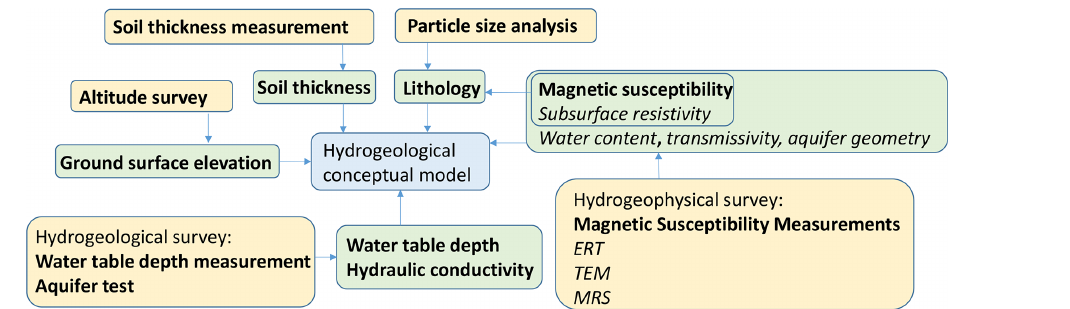
Figure 2. Fieldwork workflow for setting up a hydrogeological conceptual model at Maqu catchment, where italics represent indirect technique (e.g. inversion type of retrieval) with unknown uncertainty, regular bold letters represent direct technique with low uncertainty, and regular letters do not convey uncertainty